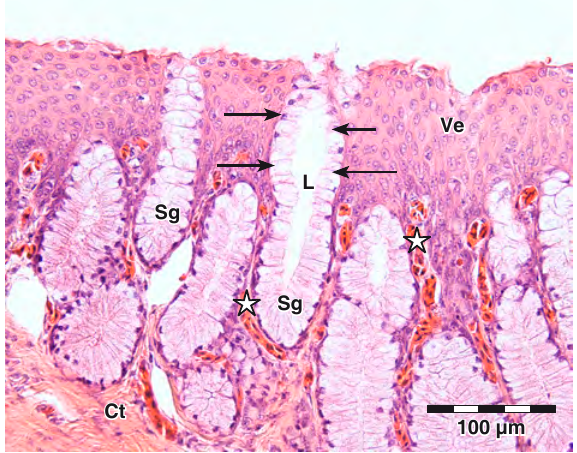
Caudal aspect of the tongue ventrum illustrating the small, simple tubular mucus­secreting glands (Sg) opening onto this surface. The glands are seen in lon­ gitudinal section with much of their length restricted to the epithelial layer. The lumen (L) is lined by secretory cells (arrows). Capillaries (stars), connective tissue (Ct), ventral epithelium (Ve)